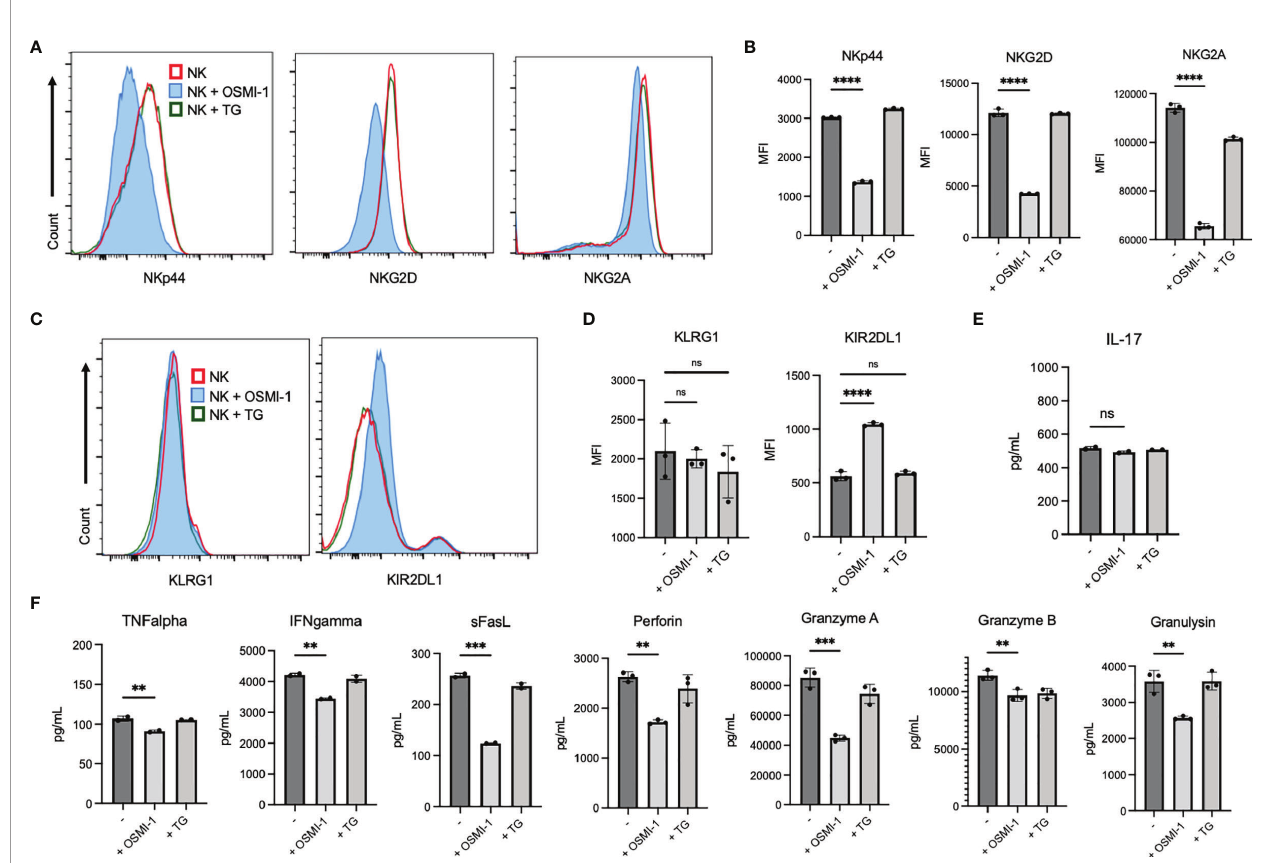
FIGURE 2 | Receptor expression and cytokine secretion are altered in a pattern suggestive of decreased cytotoxicity with OSMI (25 µM) but not TG (50 µM) treatment. (A – D) Primary NK cells were treated with OSMI-1 (25 µM) and TG (50 µM) for 24 h, and surface receptor expression was analyzed. Primary cells were gated as CD3 [FITC (Fluorescein isothiocyanate)] negative and CD56 (APC) positive to indicate the NK population. Flowcharts ( A/C ) and graphical representations of MFI (B, D) from gated primary NK cells are shown. (A, B) Display of receptors that are downregulated. (C, D) Display of receptors that display no change or increased surface expression. (E, F) Primary NK cells were incubated in OSMI-1 and TG for 36 h, and cytokine expression was analyzed of supernatants at 1:10 and 1:100 dilution depending on cytokine abundance via LEGENDplex. Cytokine values calculated off of standard curve and back calculated using their respective dilutions. (E) The picograms (pg)/milliliters (ml) of IL-17 expression determined by LEGENDplex and subsequent fl ow cytometry do not signi fi cantly change. (F) Cytokines that are signi fi cantly decreased in the NK + OSMI-1 (25 µM) treatment group as determined by LEGENDplex and subsequent fl ow cytometry. Receptor analysis and cytokine analysis was determined via one-way ANOVA with Dunnett ’ s multiple comparisons to the untreated (-) NK group mean. NS indicates no signi fi cance. ** indicates signi fi cance p <.01, ***p <.001, ****p <.0001. Error bars are standard deviation of the mean. Experiments 2A and 2D were performed three times, and 2E was performed twice. Individual values represent individual cell culture wells. Experiments chosen are